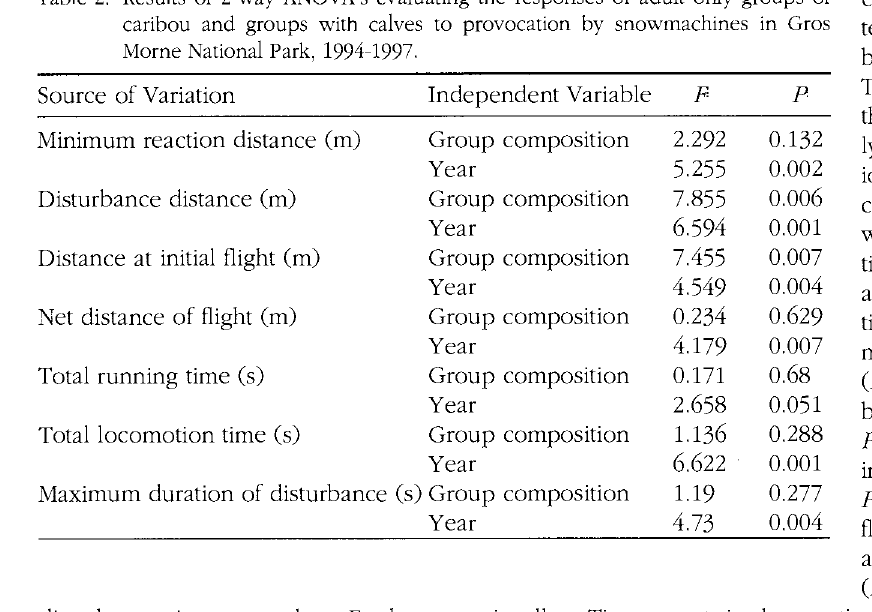
Table 2. Results of 2-way ANOVA's evaluating the responses of adult only groups of caribou and groups with calves to provocation by snowmachines in Gros Morne National Park,